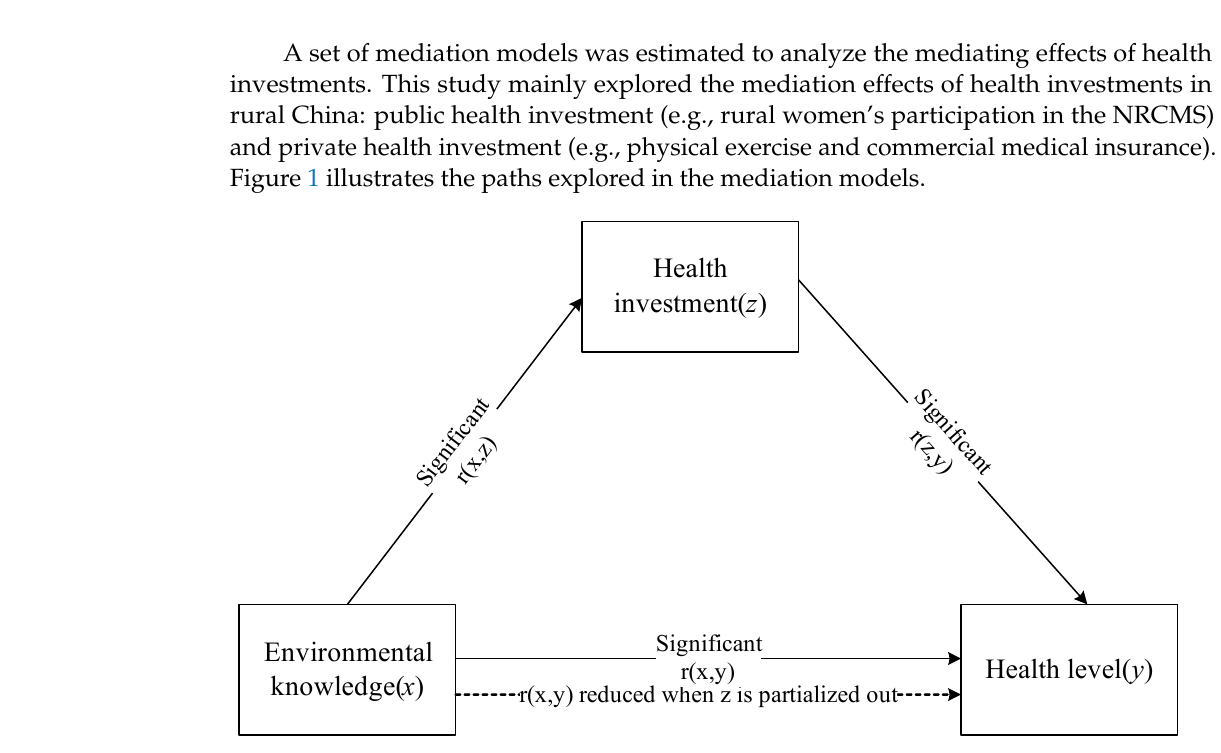
Figure 1. Illustration of mediation analysis model: the impact of environment knowledge (x) of women in rural China on their health level (y) is mediated by the respondents’ health investment (z).